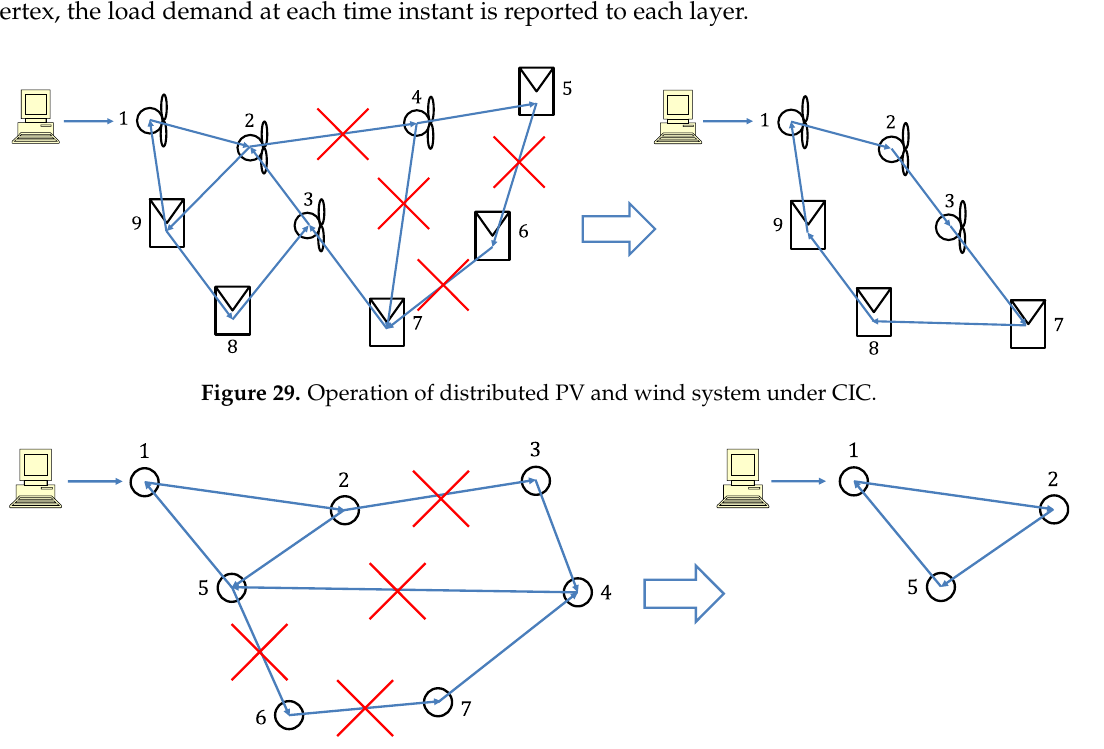
Figure 30. Operation of distributed CG system under CIC.